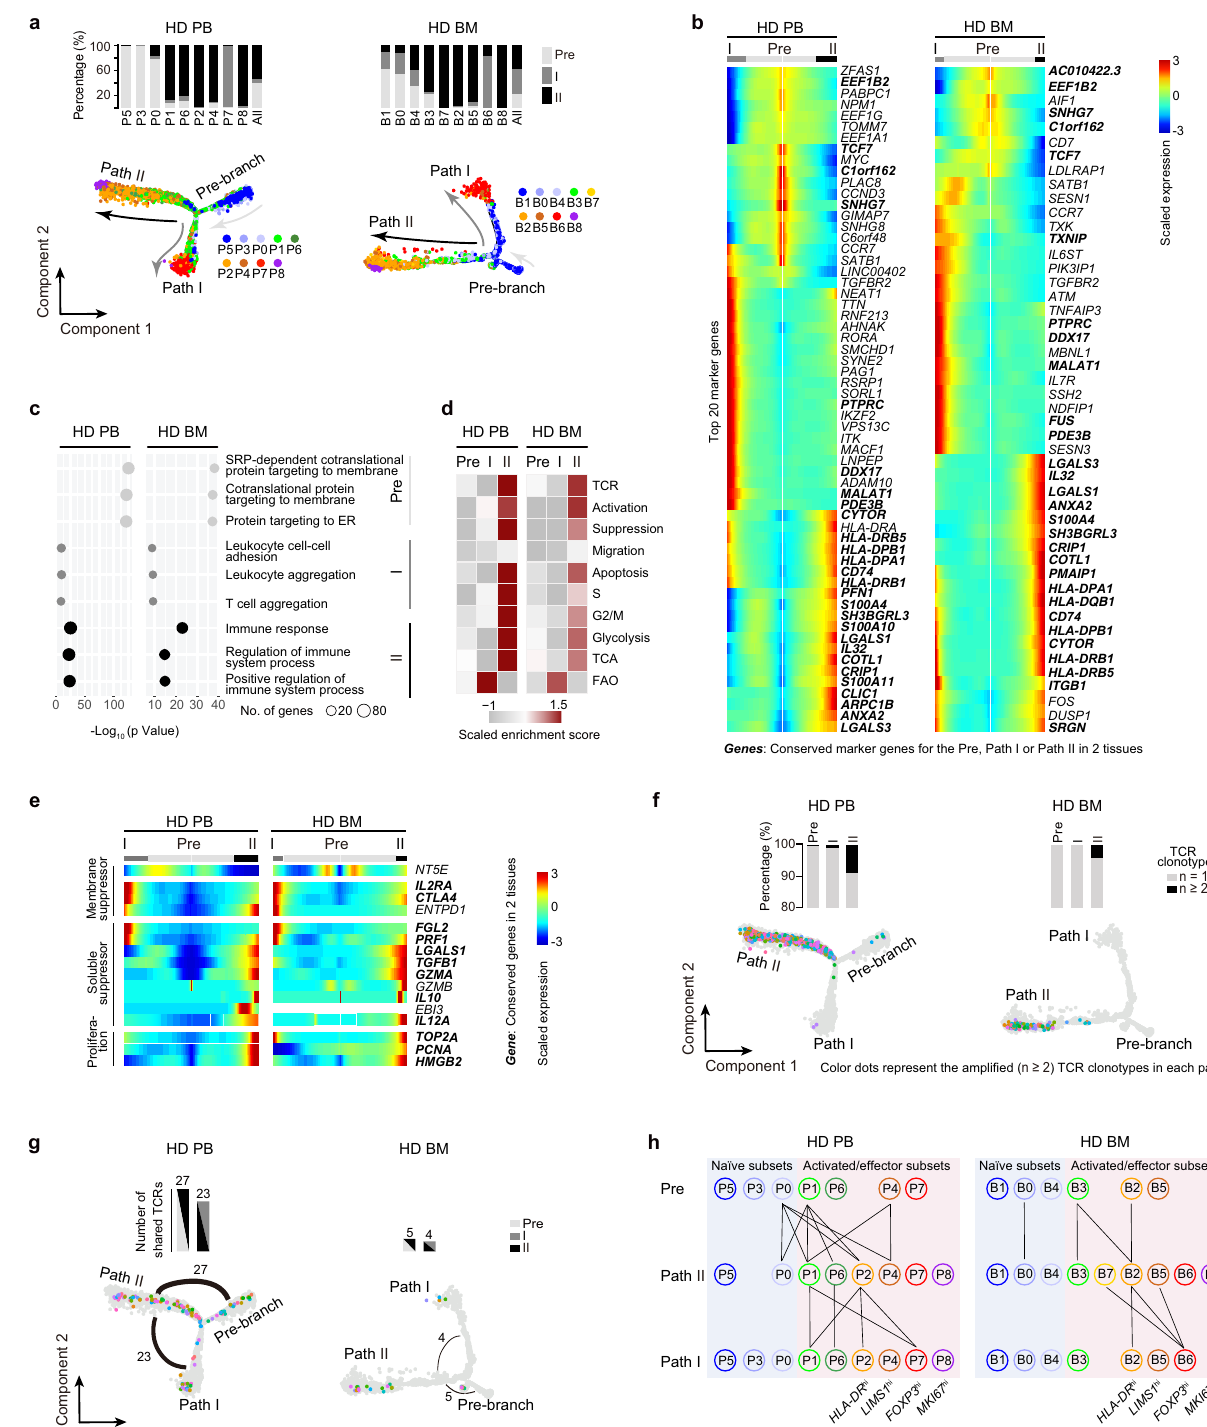
Color dots represent the shared TCR clonotypes by two paths Black lines connect two subpopulations in distinct paths, which contain shared TCR clonotypes Fig. 3 Pseudotime analysis and scTCR analysis de fi nes two differentiation paths. a Pseudotime trajectory of T reg cells within distinct tissues, colored by subsets. The insert picture shows the proportions of different T reg cell paths in each cell subset (HD PB: n = 5, HD BM: n = 3). b Pseudotemporal gene- expression pro fi les of the top 20 (by fold change) marker genes for each path, excluding the ribosomal and mitochondrial genes. c Representative terms from Gene Ontology enrichment analysis of the differentially expressed genes for each T reg cell path. d Heatmaps showing the GSVA enrichment score of T reg cell feature pathways for each different path. e Pseudotemporal gene-expression pro fi les of suppression and proliferation-associated genes in the T reg cell paths. f The ampli fi ed TCR distribution of T reg cells across different paths, colored by TCR clonotypes. The insert pictures show the composition of unique and ampli fi ed ( n ≥ 2) T reg cell TCR clonotypes in each path. g The shared TCR distribution of T reg cells between any two paths, colored by TCR clonotypes. The thickness of the black solid lines representing the relative numbers of shared TCRs. The insert pictures show the numbers of TCRs shared by two paths. h The shared TCR distribution of T reg cells between any two subpopulations in different paths. The black lines connected two subpopulations, which contained shared TCRs. Source data are provided as a Source Data fi